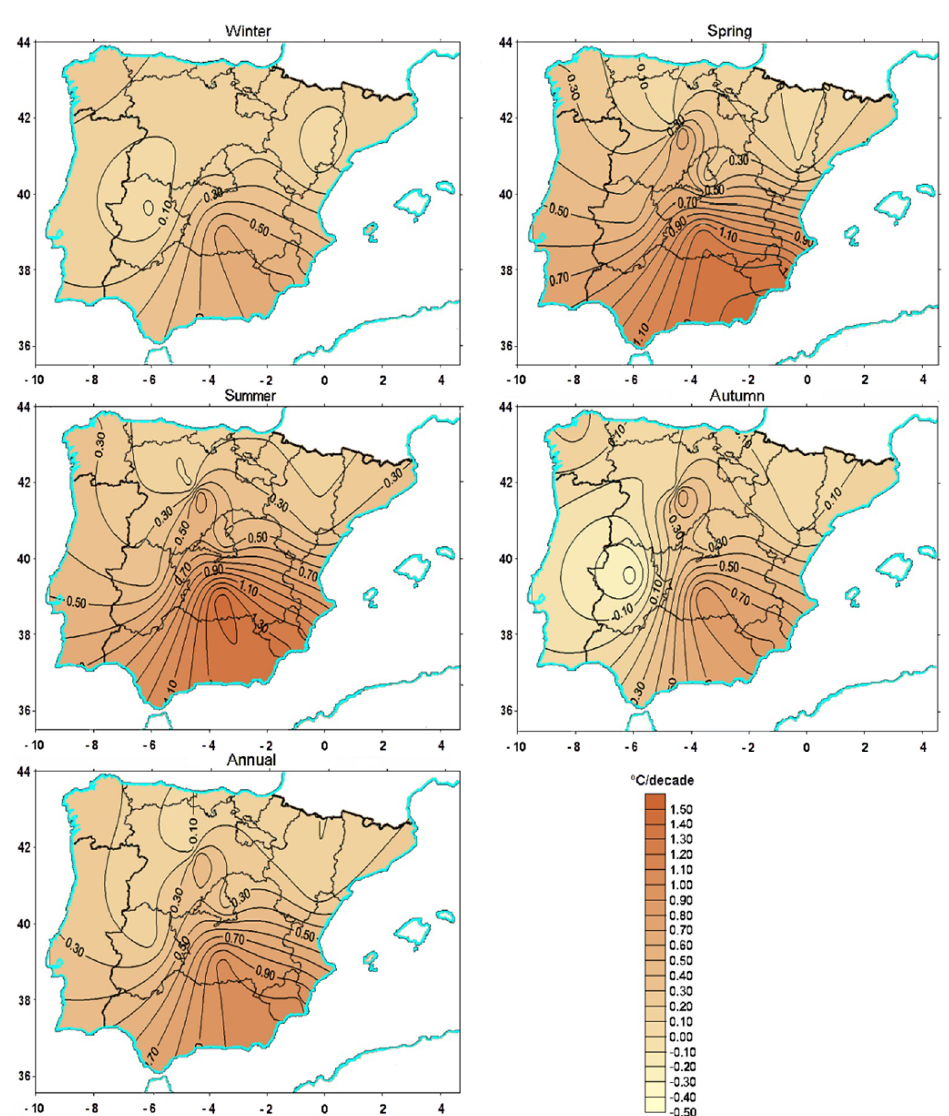
Figure 4. Isolines of seasonal and annual trends in minimum temperature anomalies in Spain over the period 1950–2011, expressed in °C decade -1 .